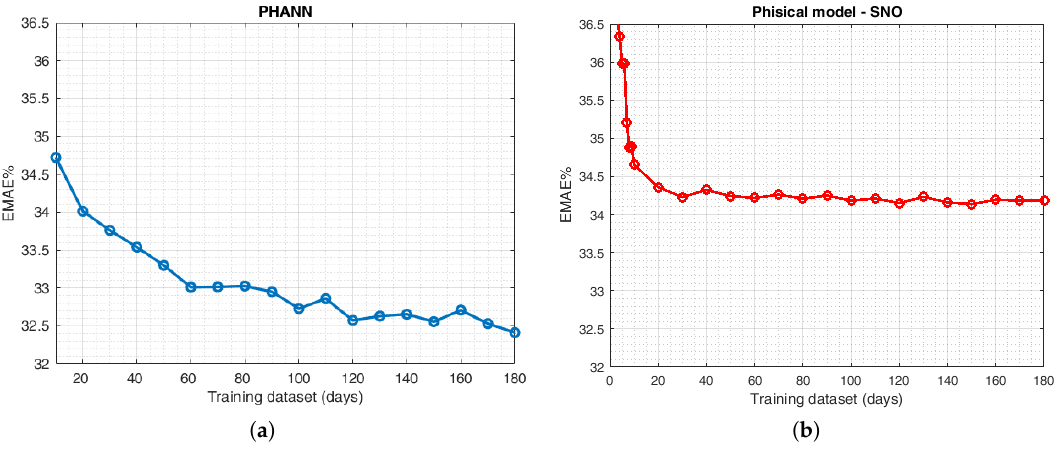
Figure 6. Training curves for 2014: ( a ) PHANN; and ( b ) physical model